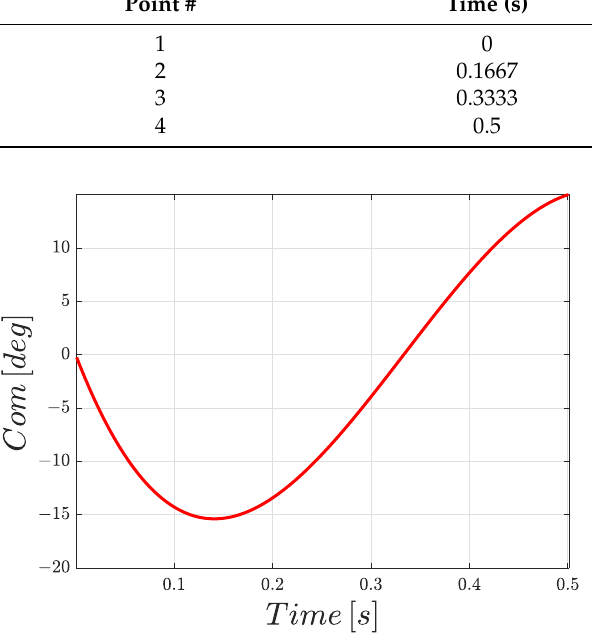
Figure 9. Elevator command curve used for the